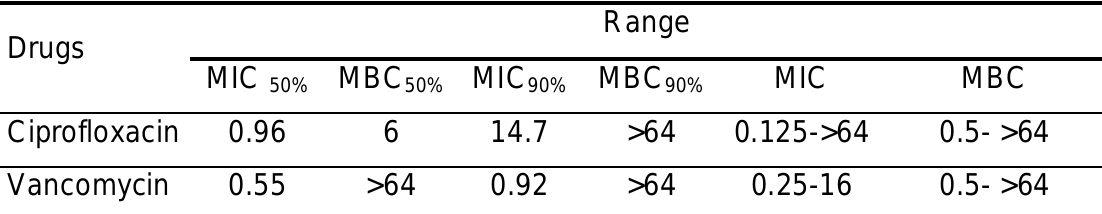
Table 3. Populational MICs and MBCs ( µ g/ml) among 74 Enterococcus faecalis